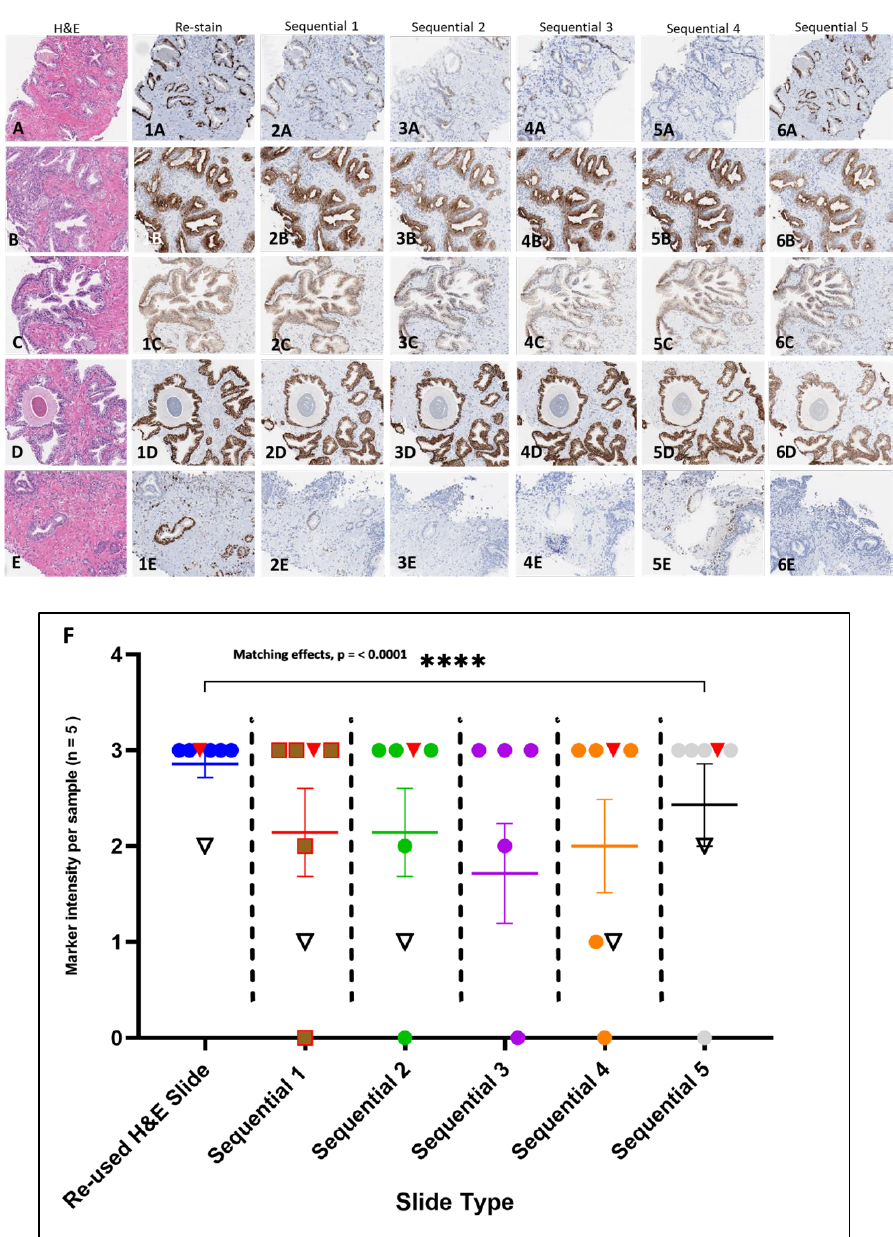
Figure 5. H&E stained slide image and reused H&E slide selected antibody immunostain